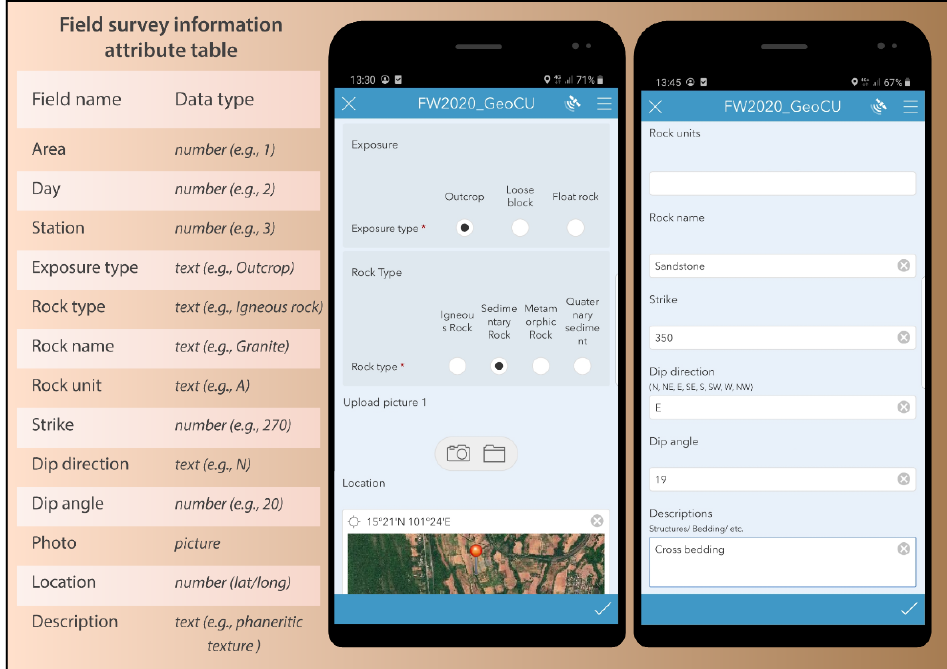
Figure 2. Field survey information and data type for generating a survey form and image of the Survey123 application on the smartphone. The necessary geological information can be collected and recorded via smartphone through online and offline modes ( left ). A screenshot of the Survey123 application shows an example of the interface of the survey used in this study ( right ).